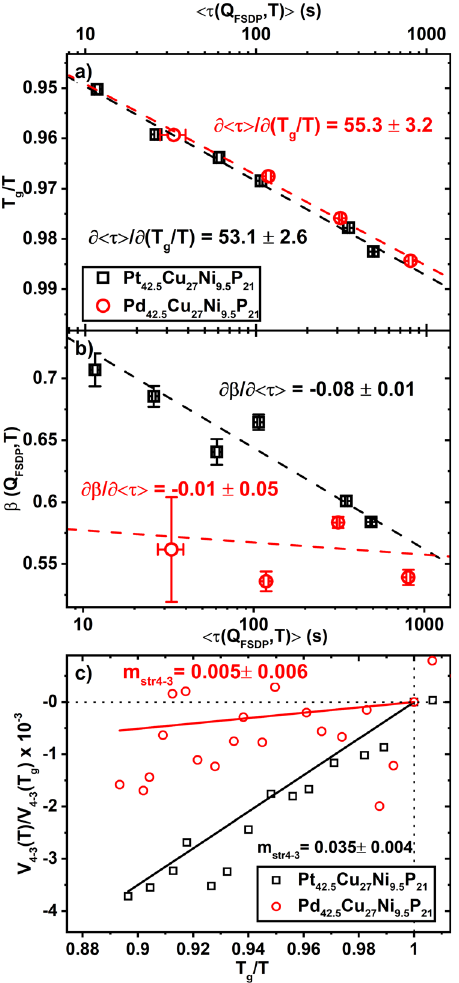
Fig. 3 Temperature evolution of the dynamical parameters and of the structure on the medium-range order (MRO) length scale. a Glass transition temperature-scaled (for a cooling rate of 1.5 K min − 1 ) fragility plot of the mean relaxation time < τ (Q FSDP ) > for Pt 42.5 Cu 27 Ni 9.5 P 21 and Pd 42.5 Cu 27 Ni 9.5 P 21 (black squares and red circles, respectively). Solid lines are linear fi ts on the logarithmic scale underlining the similar kinetic fragility of the two liquids. Note that the slope provided in the fi gure comes from the conventional de fi nition of the kinetic fragility, m , where the axes are inverted. b Corresponding Kohlrausch-Williams-Watts exponent β (Q τ (Q FSDP ,T) as a function of mean relaxation time < FSDP ) > . The dashed lines are linear fi ts of the data on the logarithmic scale. c Evolution of normalized volume dilation of the fourth and third atomic shell from the reduced pair distribution functionV 4-3 (T)/V 4-3 (T g ) as a function of normalized inverse temperature T g /T, where T g is the glass transition temperature durin g heating with a rate of 0.33 K s − 1 . A linear fi t (full line in respective color) of the data is used to calculate the structural fragility parameter m str4-3 of the liquid phase. Error bars indicate the standard error due to fi tting of the experimental data using the Levenberg Marquardt